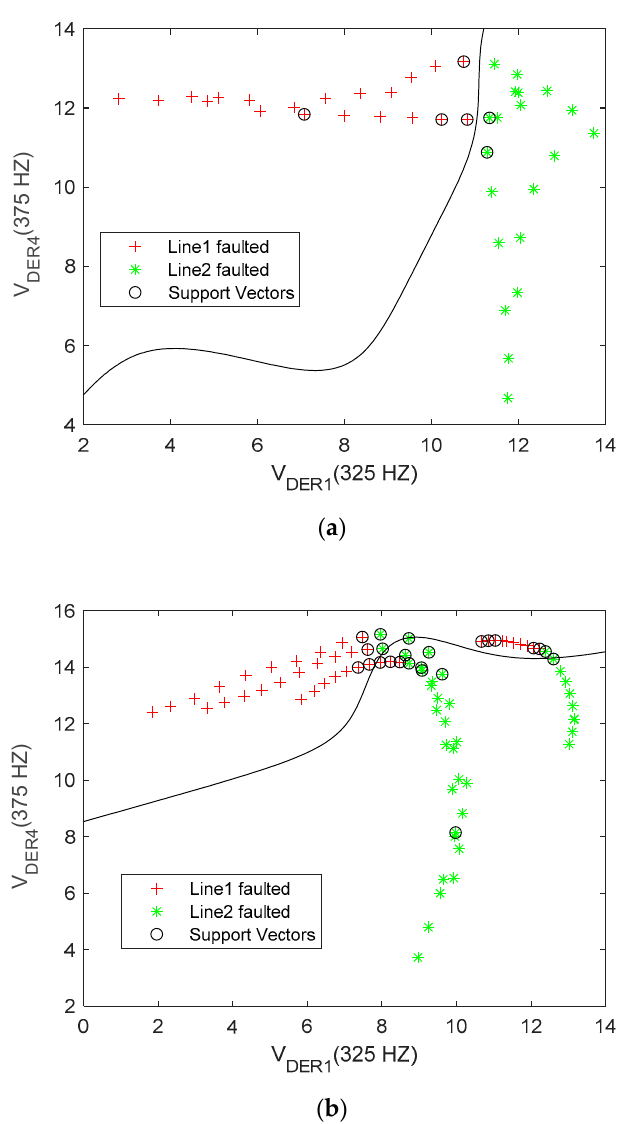
Figure 7. Detection of faulty line in zone 1 with single interharmonic injection method. ( a ) R f is fixed at 0.5 Ω , ( b ) R f varies between 0 and 6 Ω and load varies between 20 and 100%.